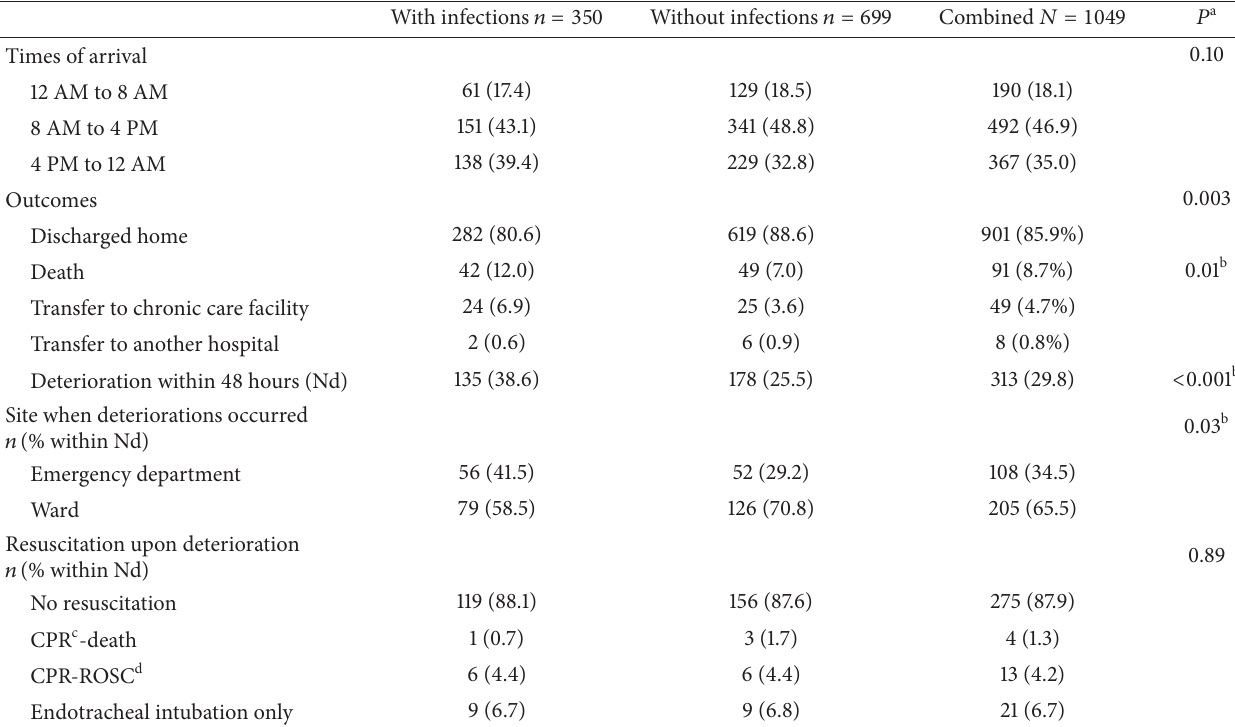
Table 2: Clinical features and outcomes in patients with infections and those without